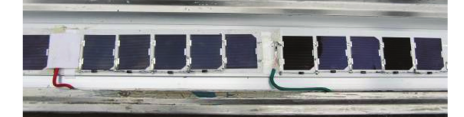
5.1. The E ff ect of the Mirror Reflectivity. The TCPV/T system reflects and concentrates the solar radiation to the focal spot by using the trough parabolic mirrors. The light intensity can be improved to a high level. It is clearly to see from Figure 7 that with increasing of mirror reflectivity from 0.5 to 0.95, the electrical e ffi ciency, the thermal e ffi ciency, and the exergy e ffi ciency increase by 0.02 times, 0.94 times, 0.62 times (for the TCPV/T system with a super cell array) and 0.65 times, 0.90 times, 0.93 times (for the TCPV/T system with a GaAs cell array). The electrical e ffi ciency of the super cell array TCPV/T system increases firstly and then drops slightly, that is, due to the concentration ratio of 8.46 is preferred for the optimum output performance of the super cell array (from [16], we can get the conclu- sion that the parabolic mirror reflectivity of the